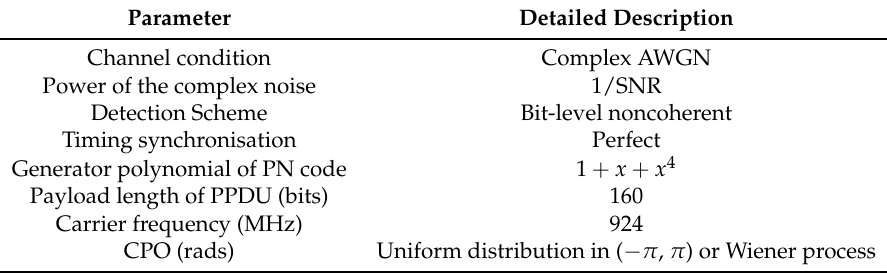
Table 2. Parameters used in simulations. AWGN: additive white Gaussian noise; SNR: signal-to-noise